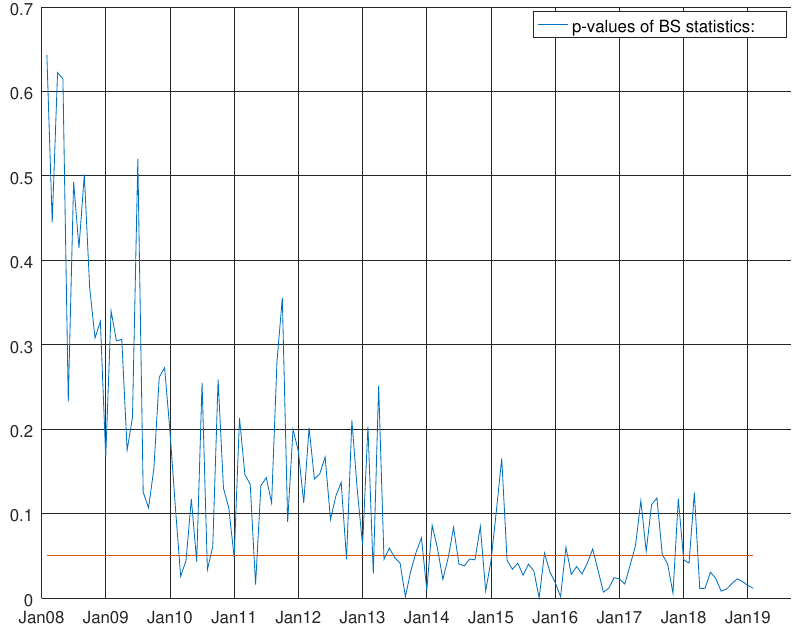
Figure 24. Graph showing the p -values of the Bowman–Shenton test for the enhanced model for non-durable goods. The null hypothesis states that errors are normally distributed.